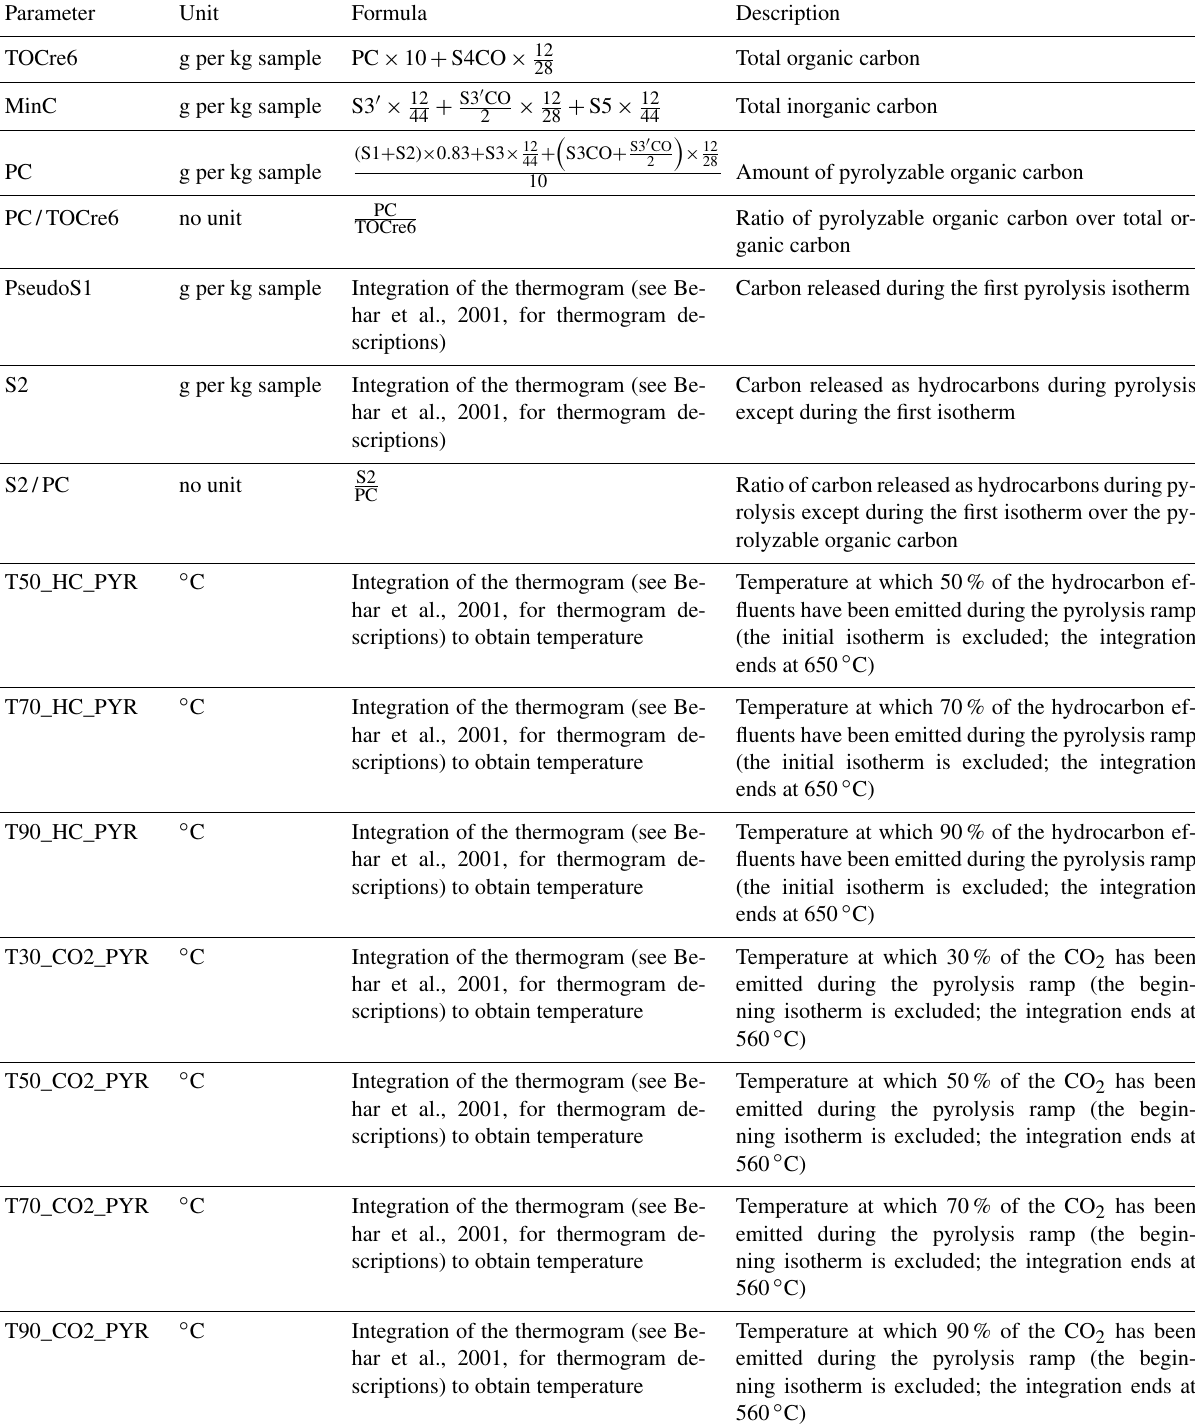
Table A1. Description of the Rock-Eval ® parameters and their calculation.